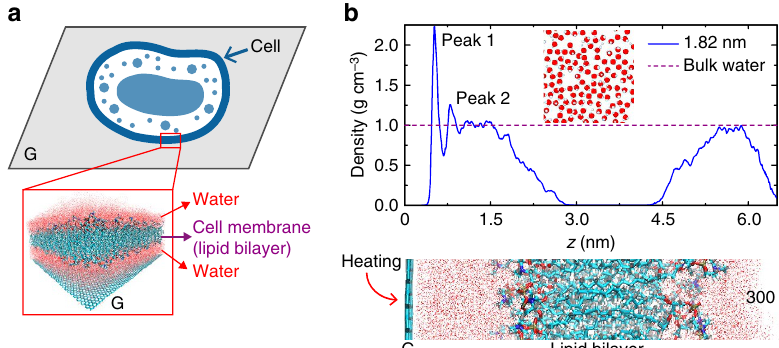
Figure 1 | Graphene–water–lipid bilayer hybrid as a model system. ( a ) Illustration and a simulation snapshot of the model under exploration. ( b ) The mass density profile of water molecules plotted with that of bulk water, along the distance measured from graphene (top of panel). The simulation set-up to explore heat transfer across the interface (bottom of panel), which is aligned with the density profile plot. The thickness of intercalated water layer is t W ¼